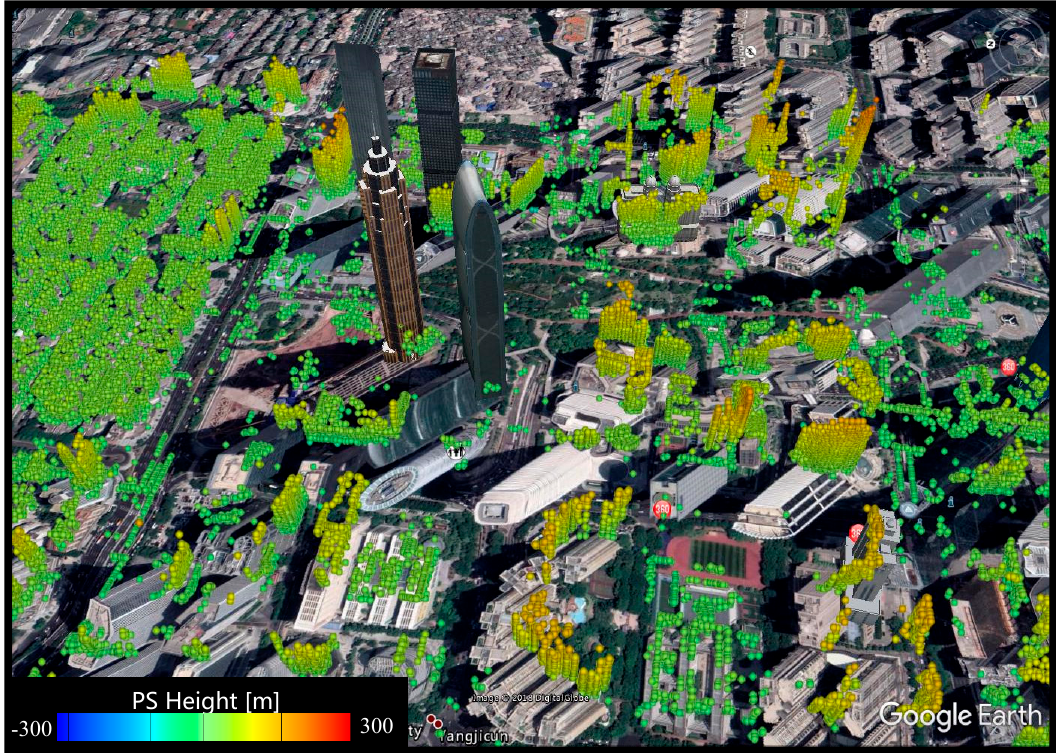
Figure 7. 3D demonstration of the highly temporal coherent persistent scatterers in test region A using standard PS-InSAR processing.